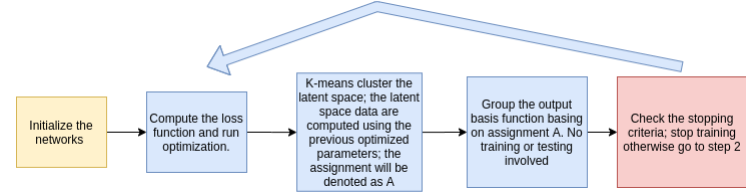
Figure 5. Deep learning